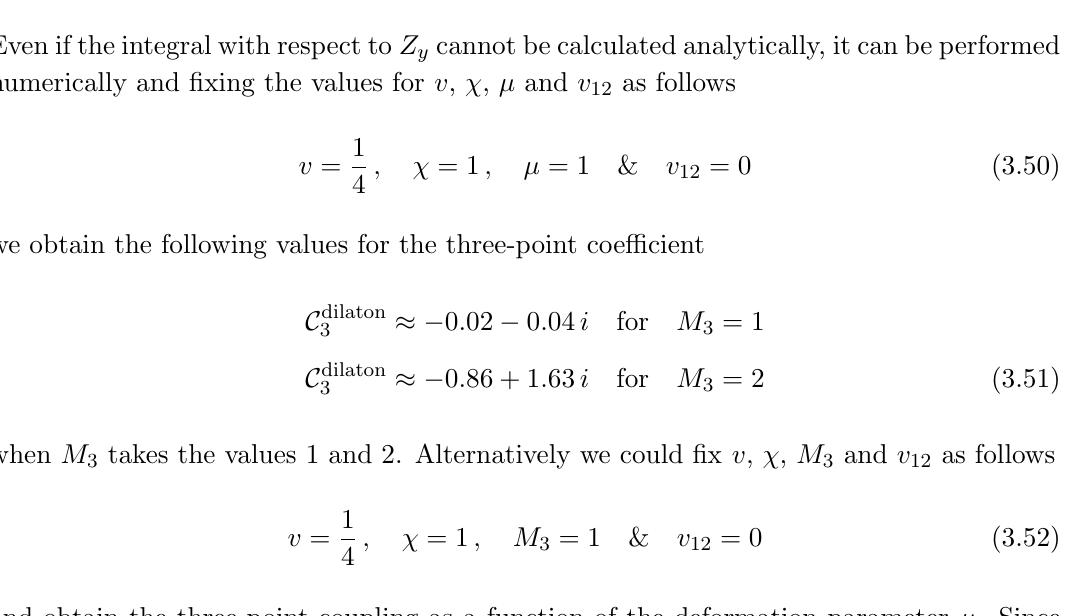
Figure 1 . Plots for the three-point coupling in (3.49) of the new solution. In the upper two panels we plot the imaginary and the real part of the three-point coupling as a function of (cid:22) while in the third panel we plot the real and the imaginary part of the three-point coupling for di(cid:11)erent values of the deformation